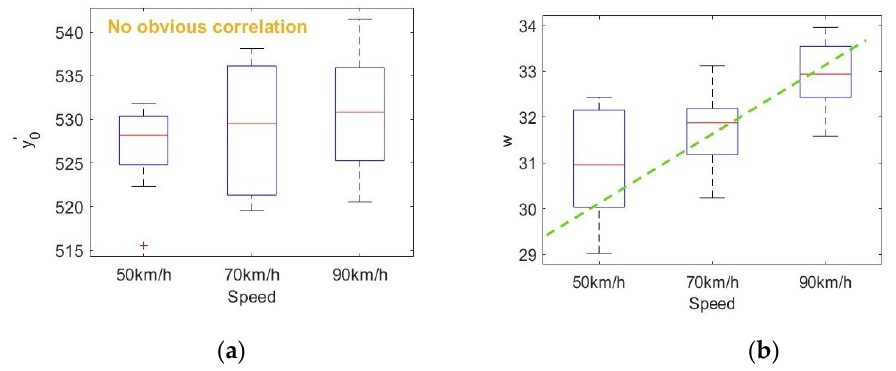
Figure 12. Relationship between fitting parameters and vehicle speed for curve with R = 800 m: ( a ) relationship between velocity and (cid:1877) (cid:2868)(cid:4593) and ( b ) relationship between velocity and (cid:1875) . (cid:2205) is the standard deviation of the longitudinal coordinate distribution of fixation points. With